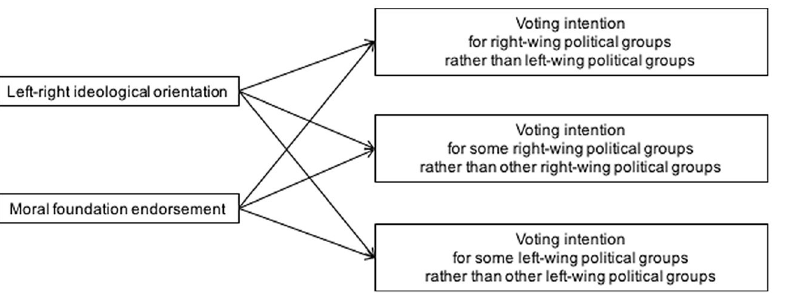
Figure 1. Conceptual diagram of the association between ideological orientation, moral foundation endorsement, and voting